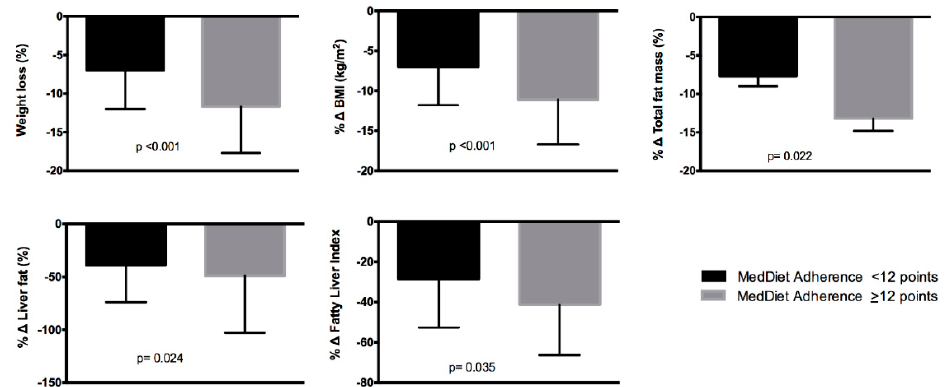
Figure 2. Weight loss percentage and percentage of changes in selected variables according to the median score of the Mediterranean Diet (MedDiet) adherence questionnaire ( < 12 points n = 30 and > 12 points n = 46) after 6 months of dietary intervention.